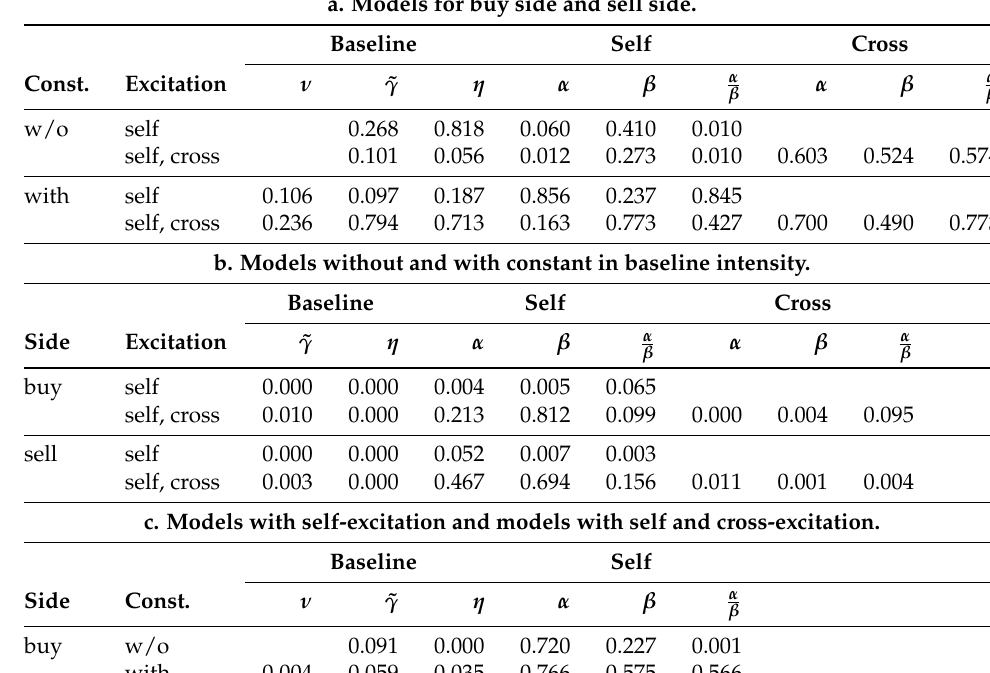
Table 5. p -values of KS tests with null hypothesis of equally distributed constants, time-zero growth components, and growth rates of the baseline intensity as well as jump sizes and decay rates of self- and cross-excitation.